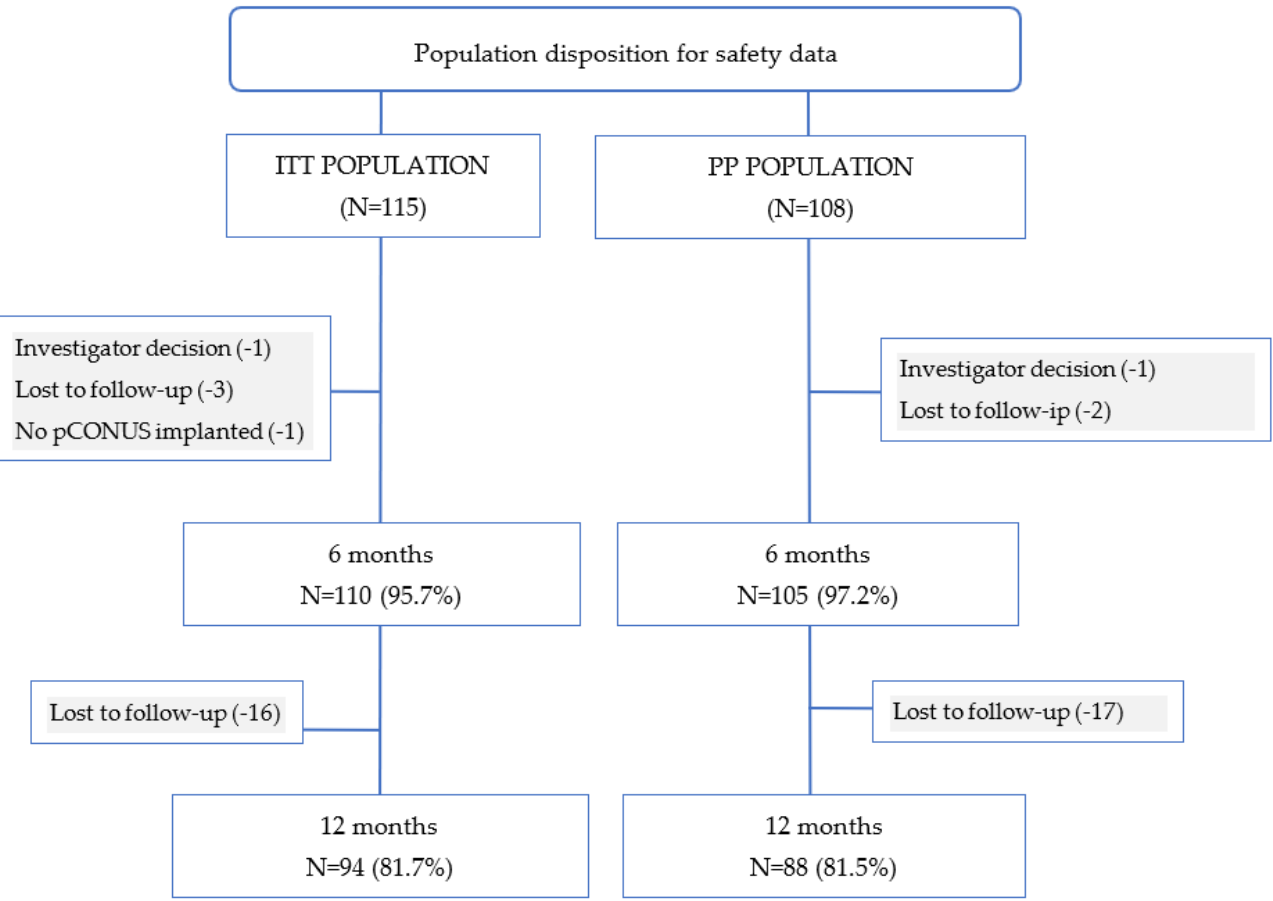
Figure 2. Population disposition for safety at 3 – 6- and 7 – 12-month follow-ups.